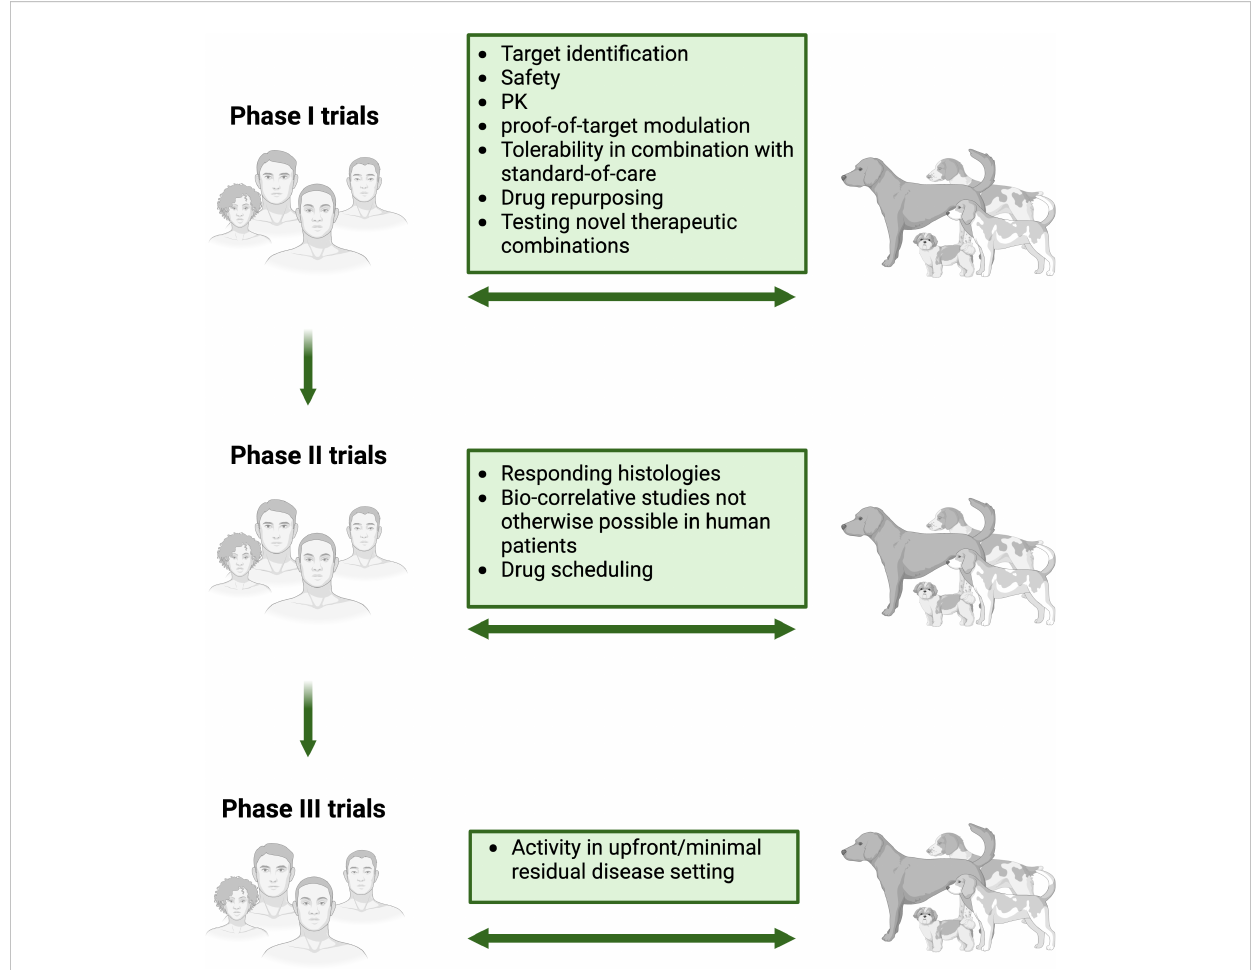
FIGURE 2 Integrating canine sarcoma trials in human oncology drug development. Considerations for the various types of clinical and biological data that can be generated through trials in dogs with spontaneous sarcoma and where in the human clinical trial pipeline integration of these data may be informative. Created with